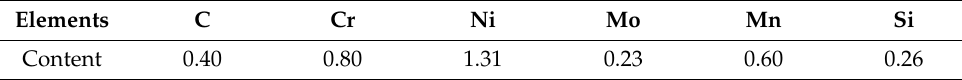
Table 3. Chemical compositions of 40CrNiMoA steel (wt.%).